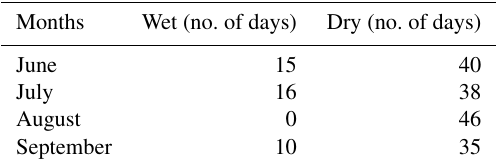
Table 1. Total number of wet and dry days during the monsoon (June–September) of 2012–2015. Months Wet (no. of